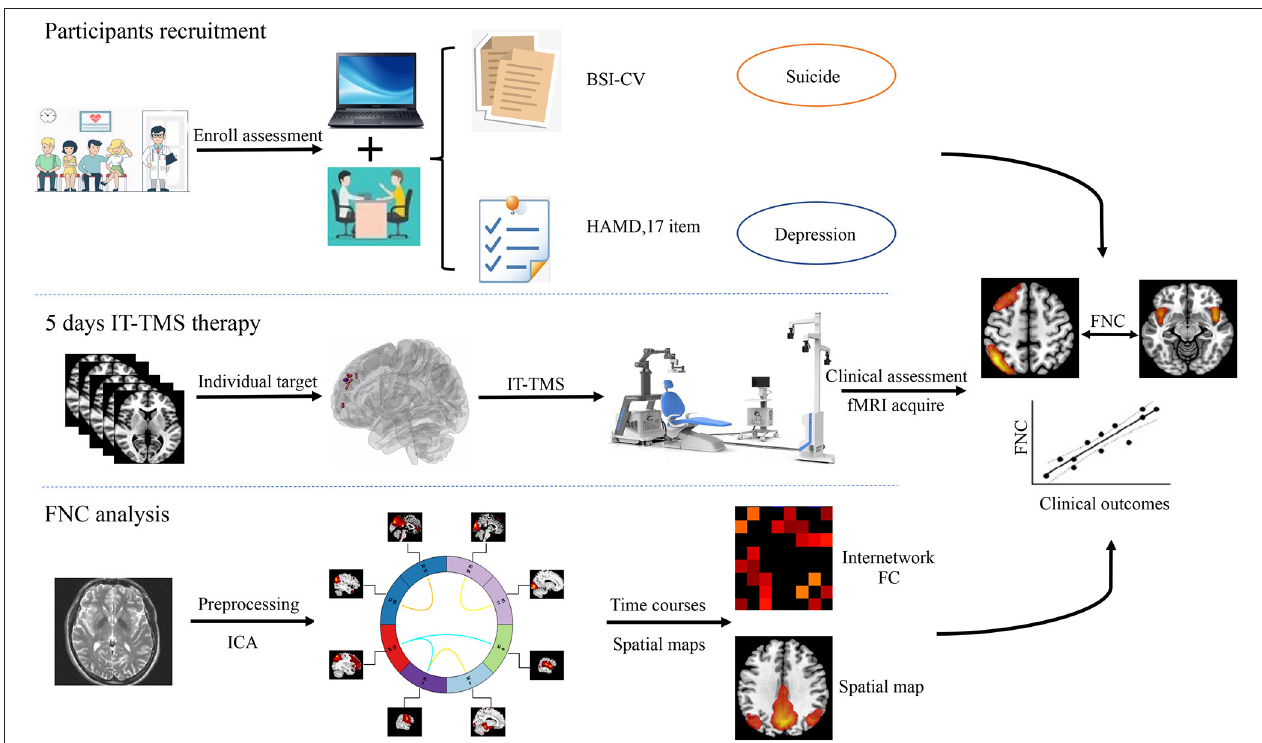
FIGURE 1 | Flowchart of this study design. IT-TMS, Individual Target-Transcranial Magnetic Stimulation; FNC, Functional Network Connectivity; fMRI, Functional Magnetic Resonance Imaging; ICA, Independent Component Analysis; BSI-CV, Beck Scale for Suicidal Ideation—Chinese Version.